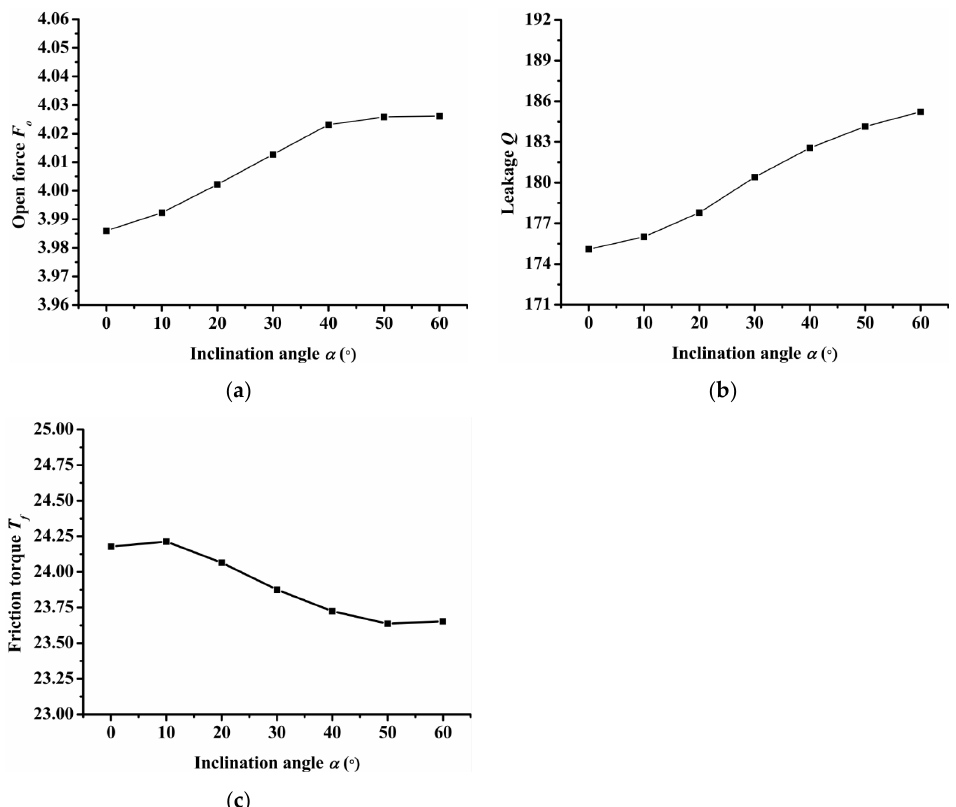
Figure 7. Influence of inclination on seal performance: ( a ) opening force, ( b ) leakage, ( c ) friction torque.